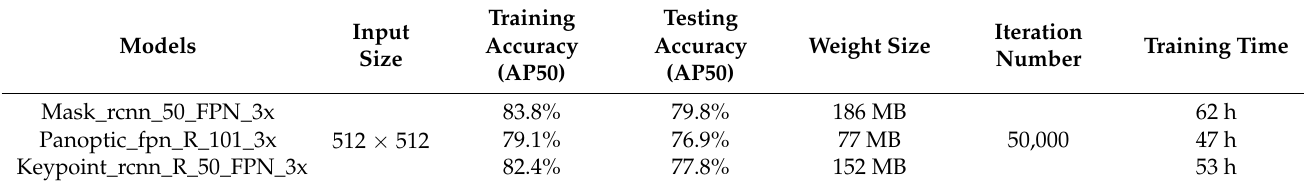
Figure 6. Fire images with different shapes ( a ) close by and ( b ) far away. ( a ) Close-distance fire images. ( b ) Long-distance fire images [6].